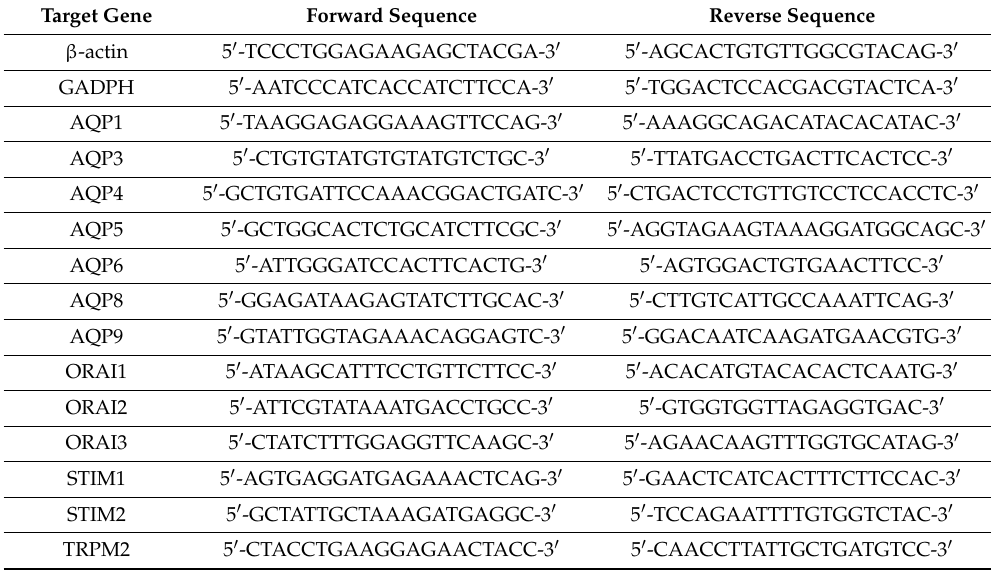
Table 1. Sequences of primers used for qRT-PCR.